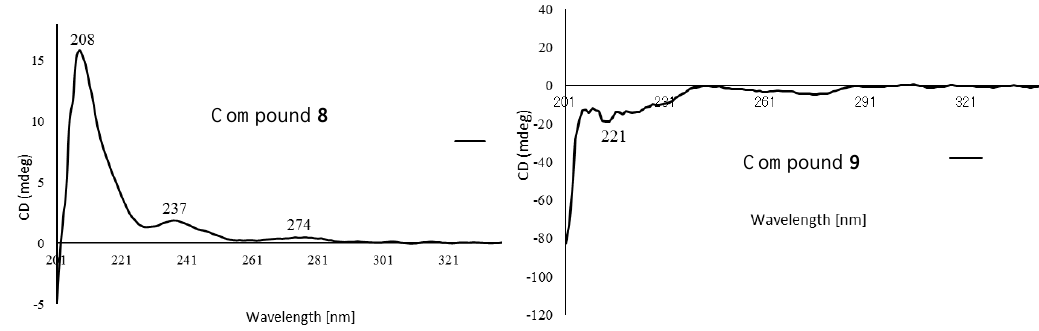
Figure 8. Experimental ECD spectra of compounds 8 and 9 .